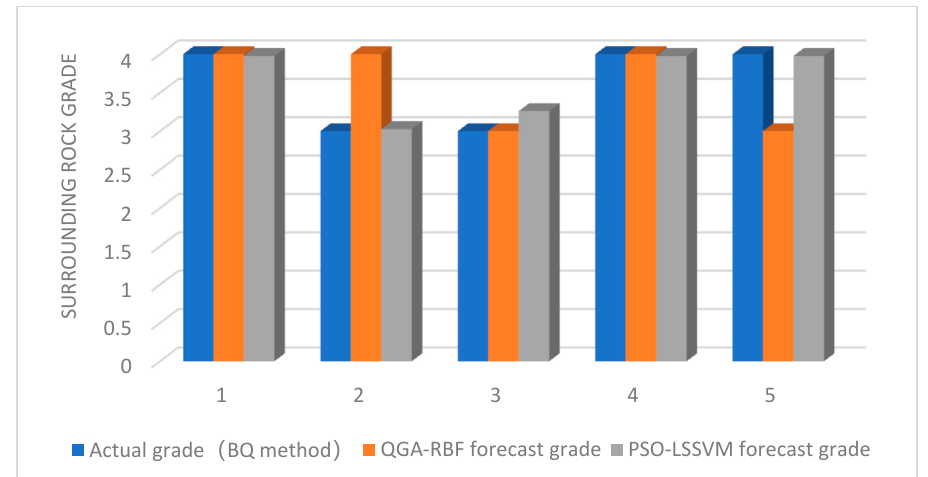
Figure 7. Model prediction for surrounding rock grades in comparison with actual rock grades.